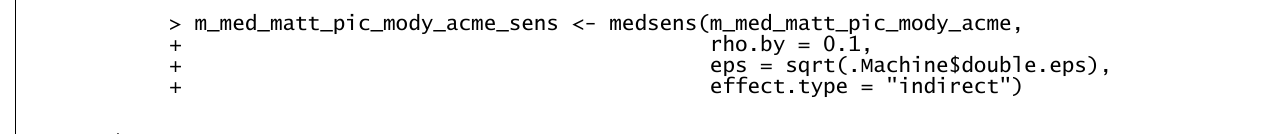
FIGURE 4 | R code for sensitivity analysis of causal mediation model with one mediator. The medsens() function takes the fitted causal mediation model from the previous step. The argument rho.by indicates the increment for the sensitivity parameter ρ .